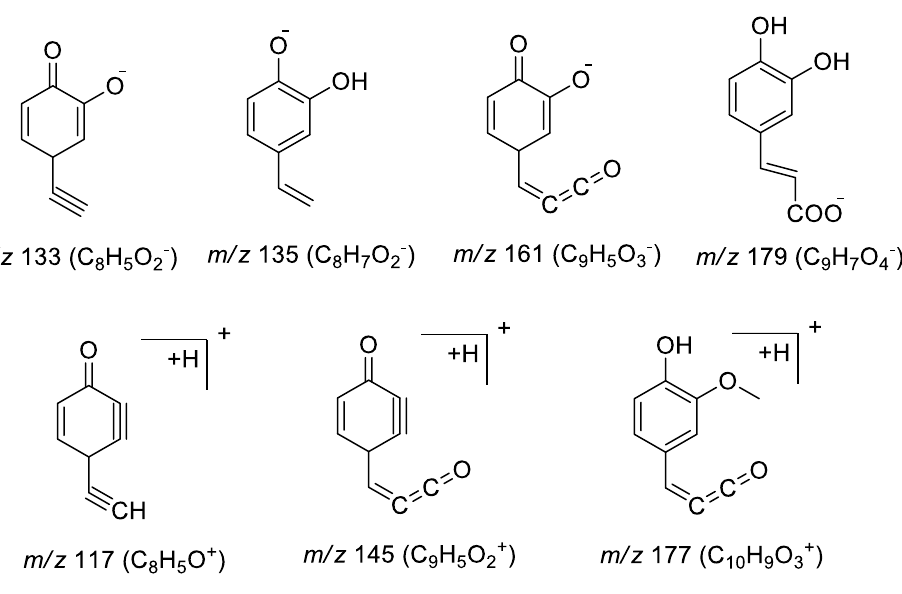
Figure 6. Proposed major fragments of phenolic compounds. + Compounds 10 , 21 , and 28 exhibited [M + H] ion at m / z 383 (C 18 H 23 O 9 ), which gave the same + fragment ion at m / z 177 [ferulic acid + H − H 2 O] , 145 [ferulic acid + H − H 2 O − CH 3 OH] + 117 [ferulic acid + H − H 2 O − CH 3 OH − CO] . According to the elution order, compounds 10 , 21 , and 28 were deduced as 3- O -feruloylquinic acid methyl ester, 4- O -feruloylquinic acid methyl ester and 5- O -feruloylquinic acid methyl ester